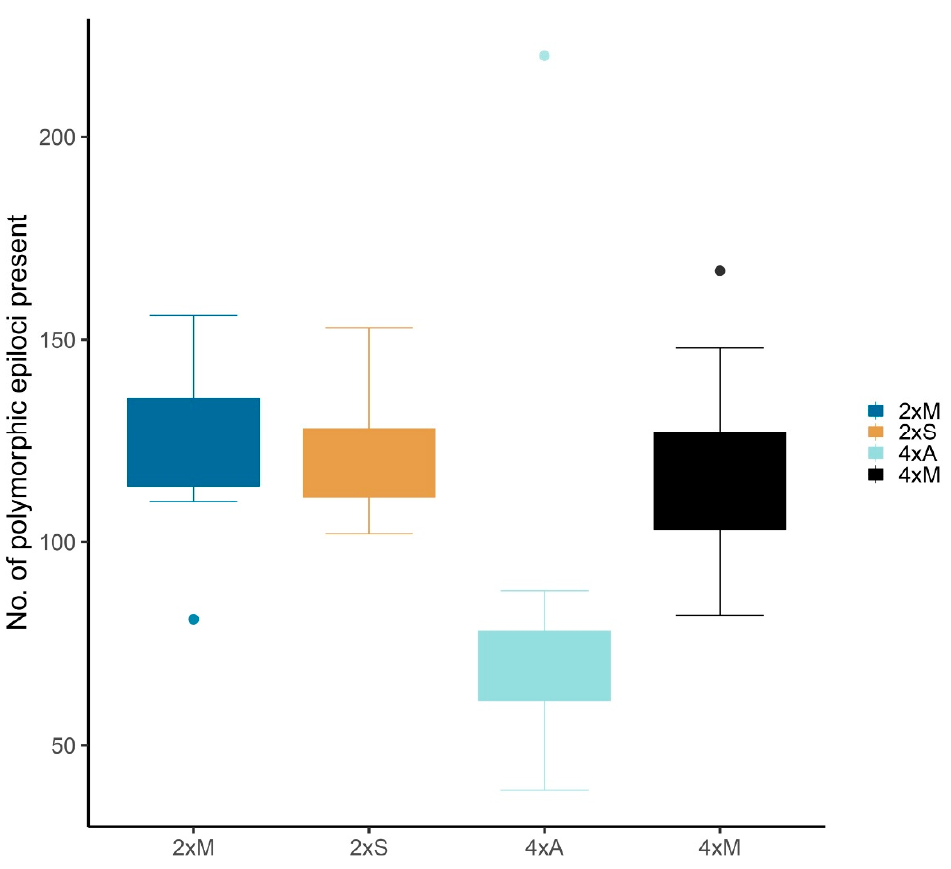
Figure 2. Boxplots of the number of polymorphic epiloci detected in 123 individuals of alpine R. kuepferi in the four combined groups (2x sexual, 2x mixed, 4x mixed, 4x apomictic; X-axis) and mode of reproduction (color code). Dots represent outliers.